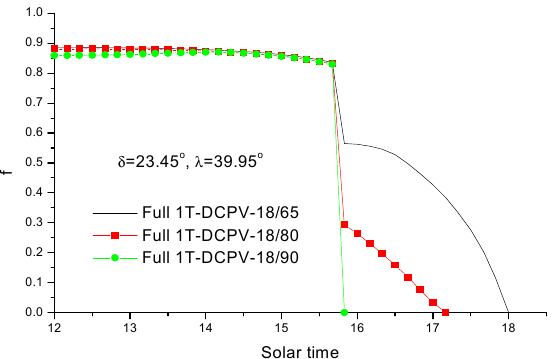
Figure 19. Time variations of optical efficiency of full 1T-DCPVs in summer solstice. Figure 19 . Time variations of optical efficiency of full 1T-DCPVs in summer solstice.